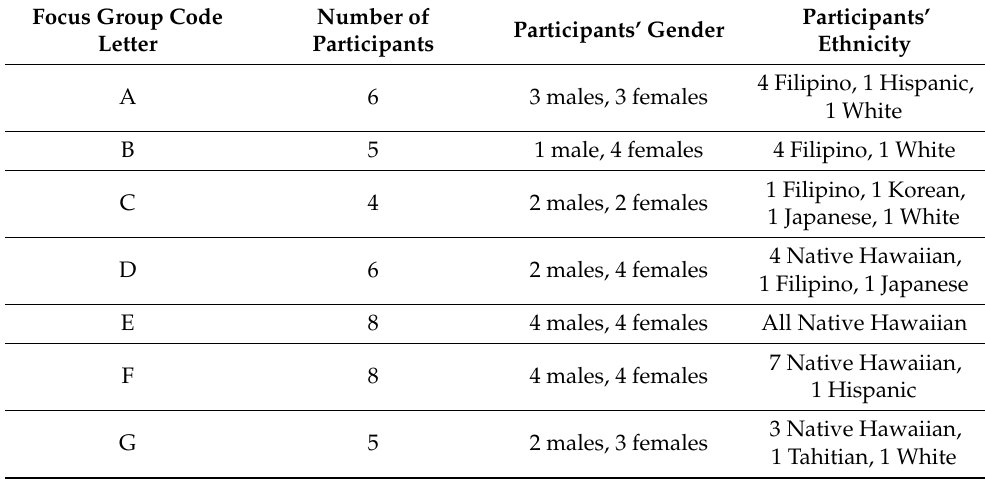
Table 1. Overview of Focus